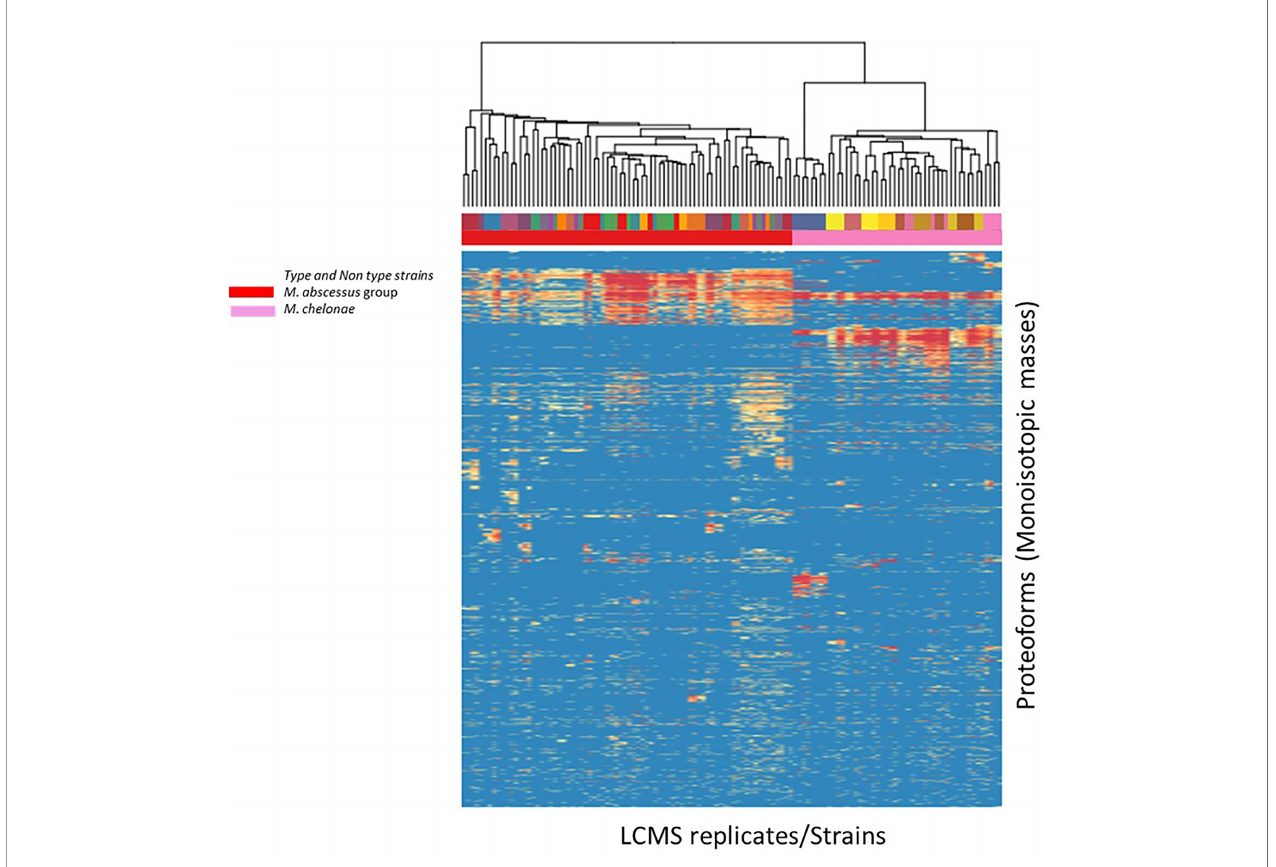
FIGURE 6 | Heat map generated for M. abscessus and M. chelonae analyzed indicating top-200 discriminatory proteoforms. Horizontal bar on top, indicates the color assignment for the type and non-type strains used in the study, horizontal bar below indicates species assignment alone for visual clarity ( M. abscessus group (red) and M. chelonae (pink)). Mass spectrometry data is here represented as a heatmap, where rows represent individual monoisotopic masses (deconvoluted protein masses) and columns individual strains (technical LC-MS replicates for each strain were merged to a single leaf in the horizontal dendrogram) of the study cohort. Data has been converted to a binary state, where 1 (red) encodes presence of a protein mass in each strain (species) and 0 (blue) encodes absence of it. The representation indicates proteoform overlap and non-overlap between strains among all species due to their closeness at species level. Unique proteoforms detected among individual species speci fi cally enable the classi fi cation down to species level (Speci fi c number of exclusive red blocks for a given taxon). Red block of proteoforms is shared between the species of interest and is non-species speci fi c (conserved). The dendrogram shows that the M. abscessus and M. chelonae clinical isolates are split in two separate branches, allowing discrimination of these fundamentally different